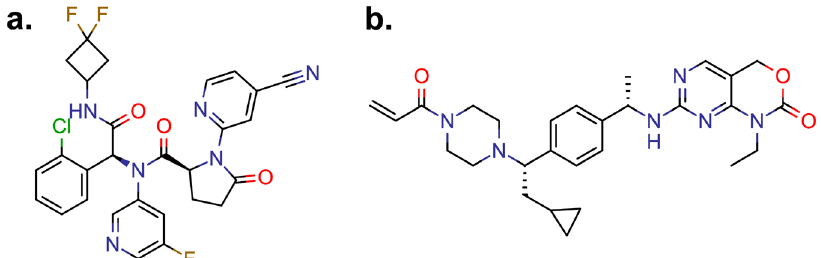
Fig. 4 Chemical structures of mutant IDH inhibitors. a The non-covalent inhibitor ivosidenib. b The covalent inhibitor